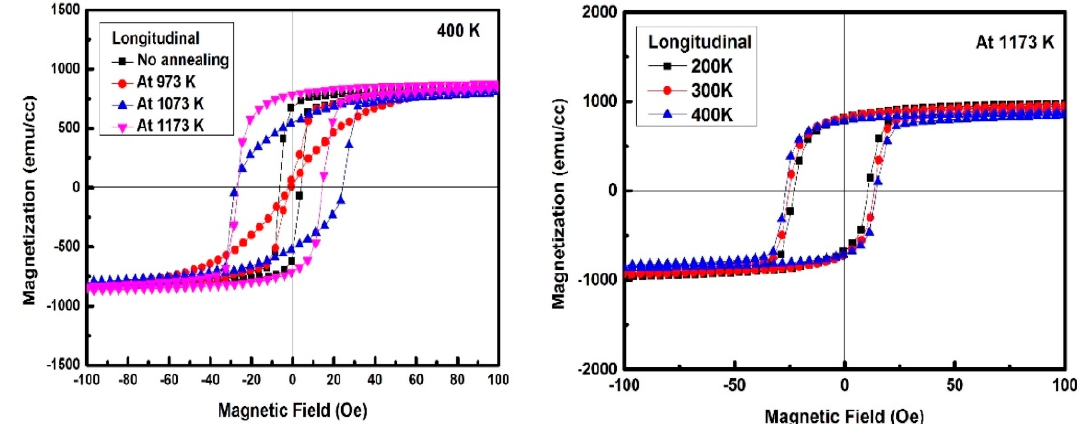
Figure 12. Hysteresis curves of a FeRh thin film, measured at 400 K after annealing at different temperatures (left panel) and measured at different temperatures after annealing at 1173 K. Reprinted with permission from [114], Copyright 2019 Elsevier.